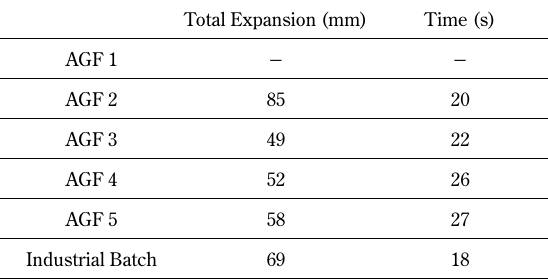
Table 6 Collapsing